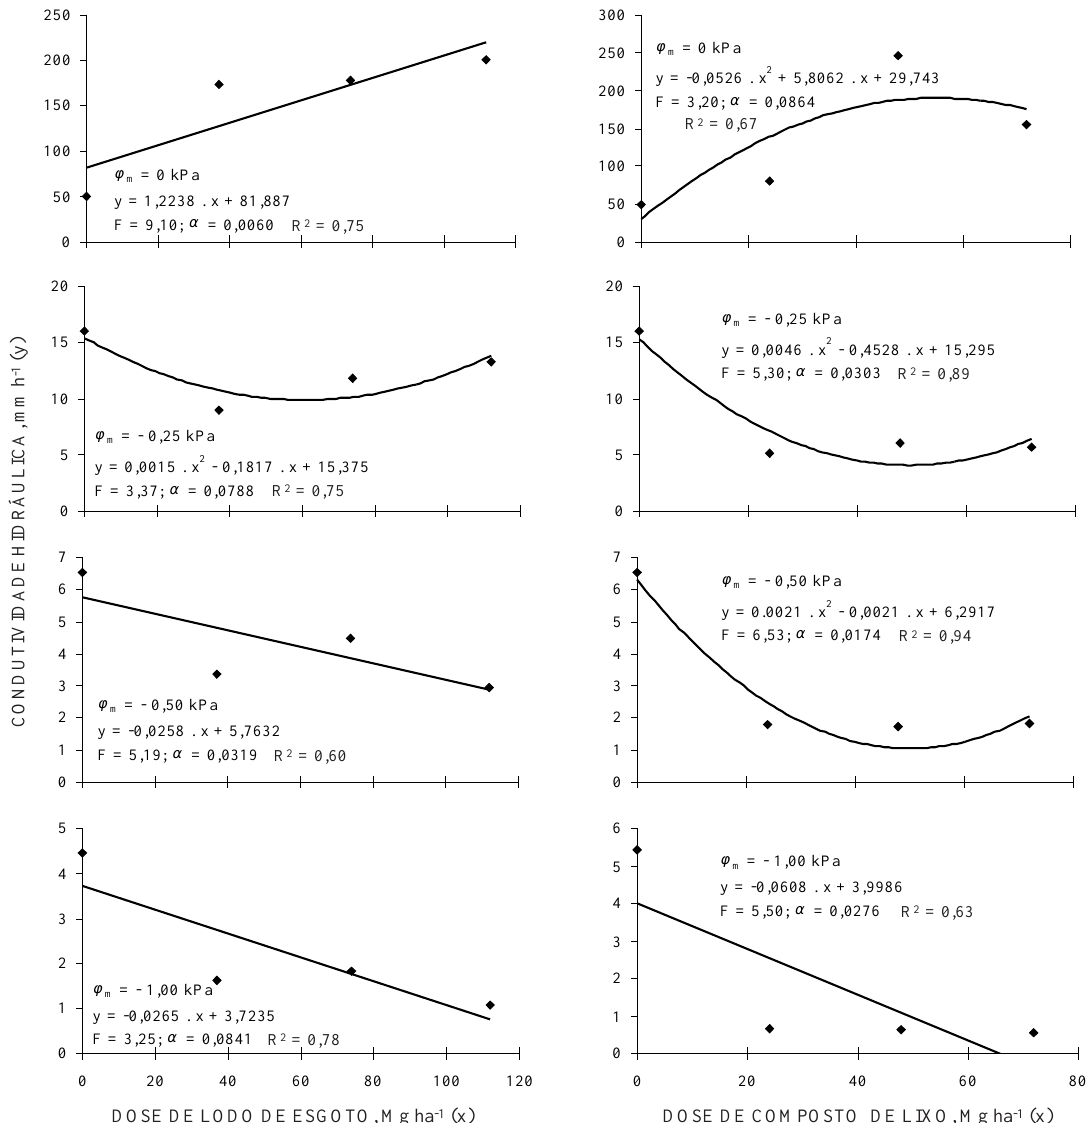
Figura 3. Valores médios para cada dose e funções ajustadas (obtidas na análise de variância a partir de 16 observações – 4 doses x 4 repetições), relacionando a condutividade hidráulica (K) com as doses de lodo de esgoto e de composto de lixo (com valor F e nível de probabilidade aaaaa ), para os potenciais mátricos onde houve significância, no segundo ano do